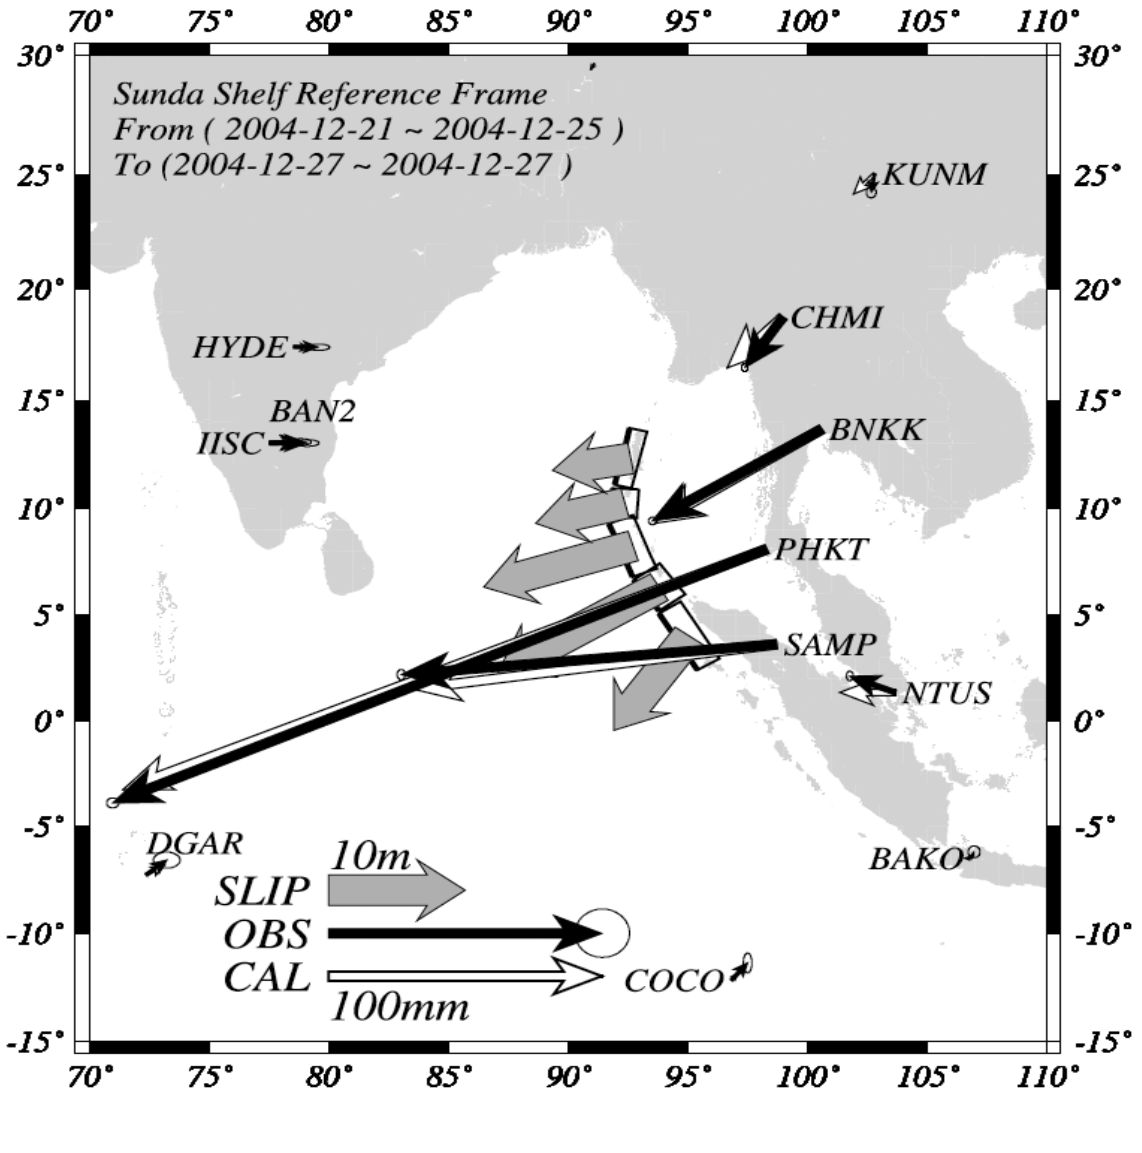
Figure 11. Co-seismic displacements from the Sumatra earthquake (M = 9.0, 26 December 2004, Indonesia). Solid and open arrows show observed by GPS and calculated displacements for the optimal model, respectively. Rectangles are surface projections of assumed fault segments whose upper margins are indicated by thick lines. Thick arrows are the estimated slip on each segment